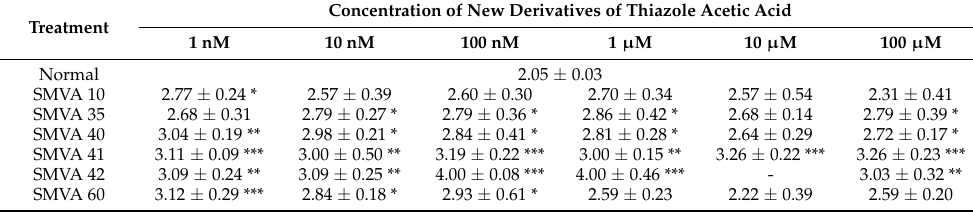
Table 1. Effects of new synthetic derivatives of thiazole acetic acid on the developed tension (gm) in isolated rat hearts.